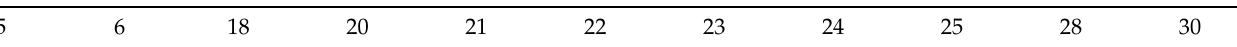
Table 2. Best relay location.